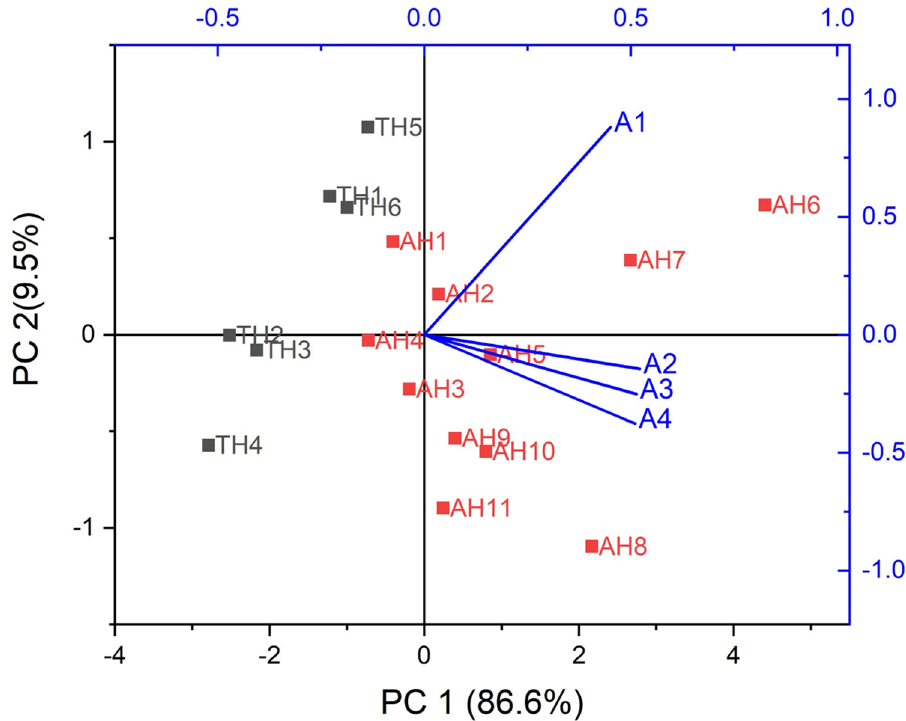
Figure 3. PCA biplot obtained for authentic honey (TH, (cid:4) ) and adulterated honey (AH, (cid:4) ) based on average RR data.